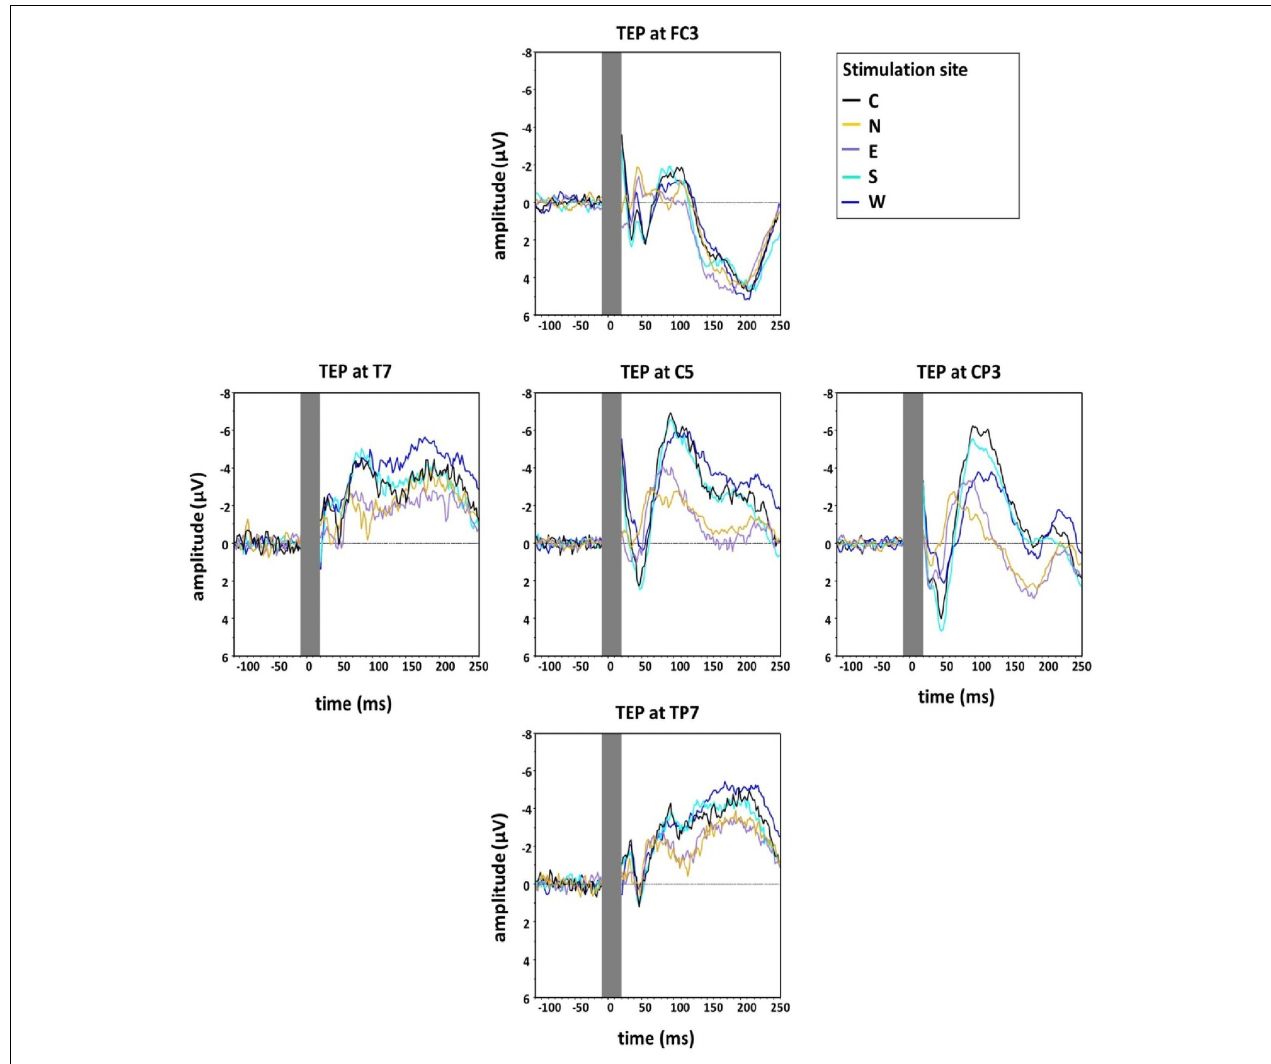
FIGURE 4 | Group grand average of N100 amplitudes at the five main directions of the grid (Central, North, East, South, West) measured at five electrodes around C5 in the directions of coil displacement (C5, FC3, CP3, TP7, T7). The TMS artefact (gray bar) has been cut